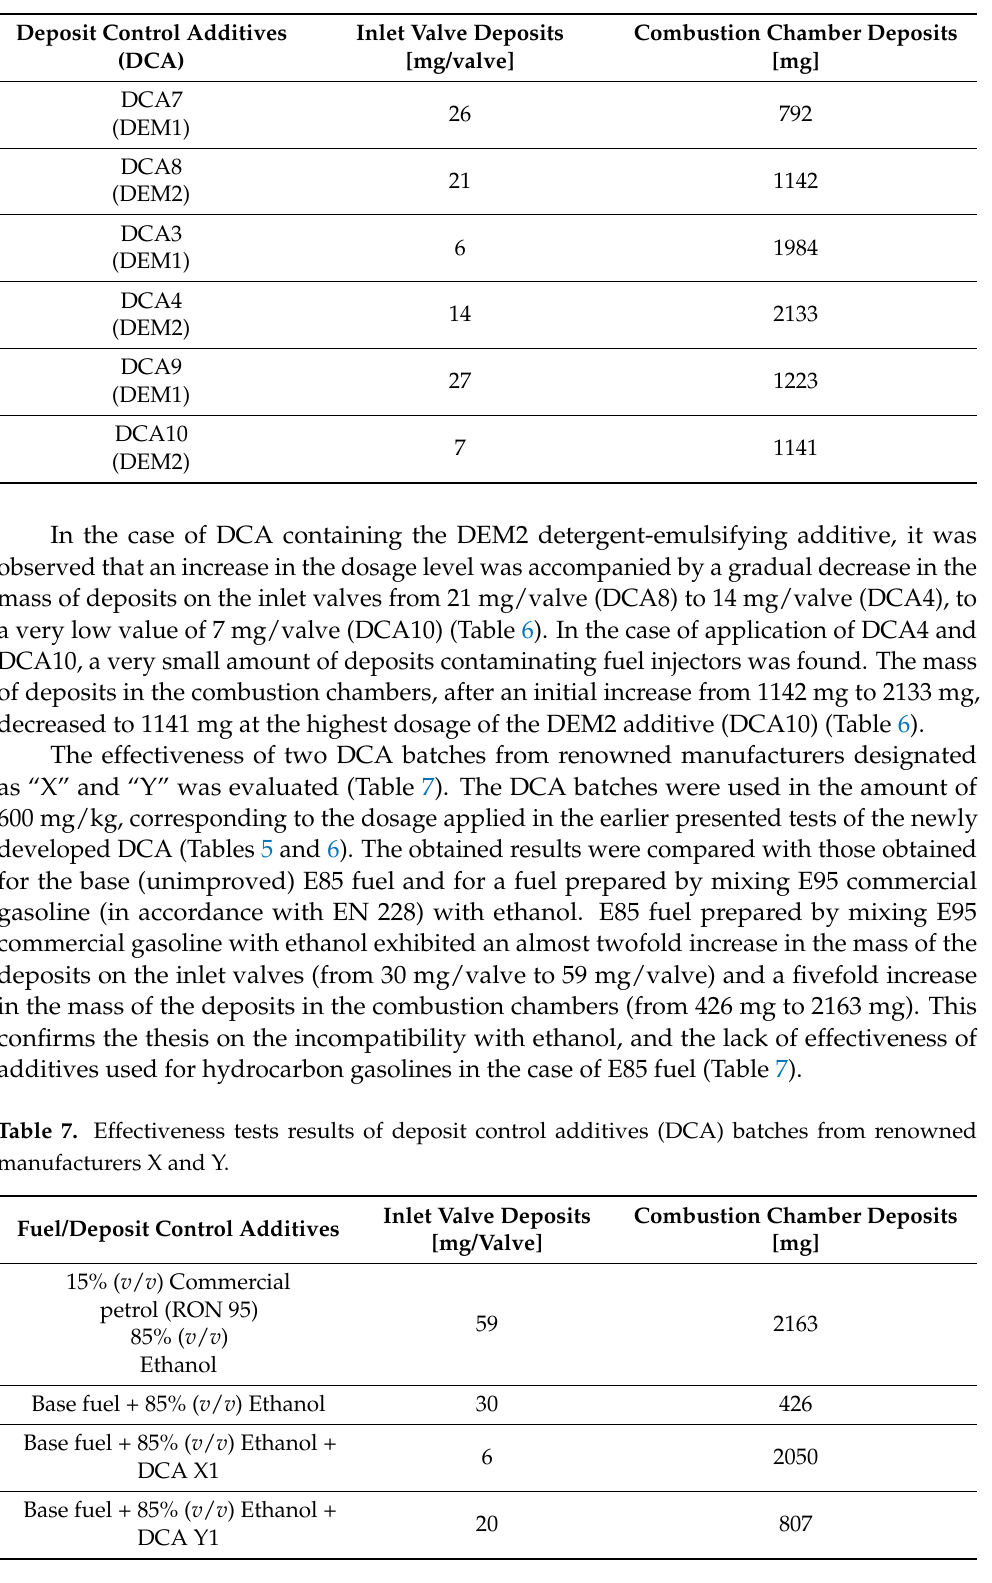
Table 6. Deposits on inlet valves, in combustion chambers, and in fuel injectors with different dosages of detergent-emulsifying additives DEM1 and DEM2.